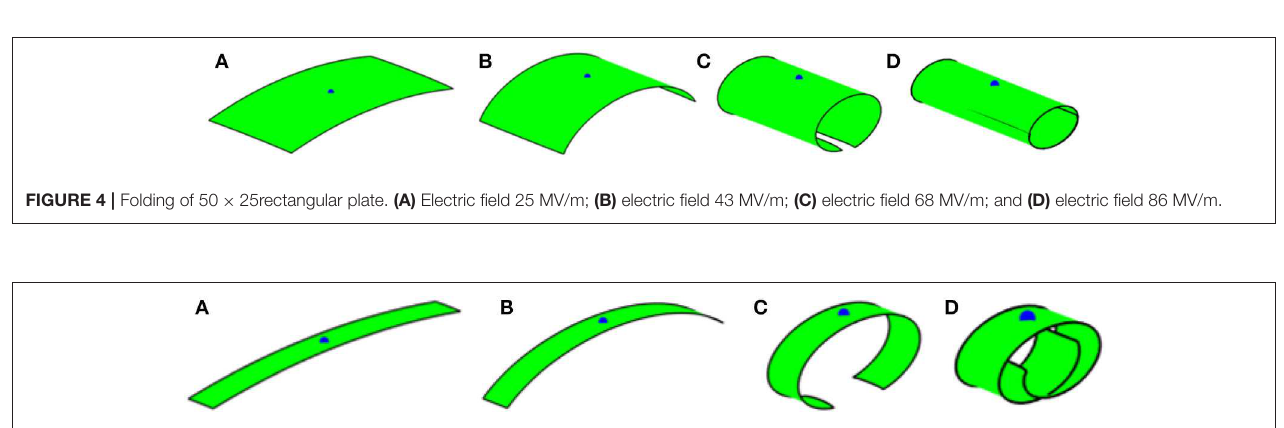
FIGURE 5 | Folding of 50 × 5rectangular plate. (A) Electric field 25 MV/m; (B) electric field 43 MV/m; (C) electric field 68 MV/m; and (D) electric field 86 MV/m.